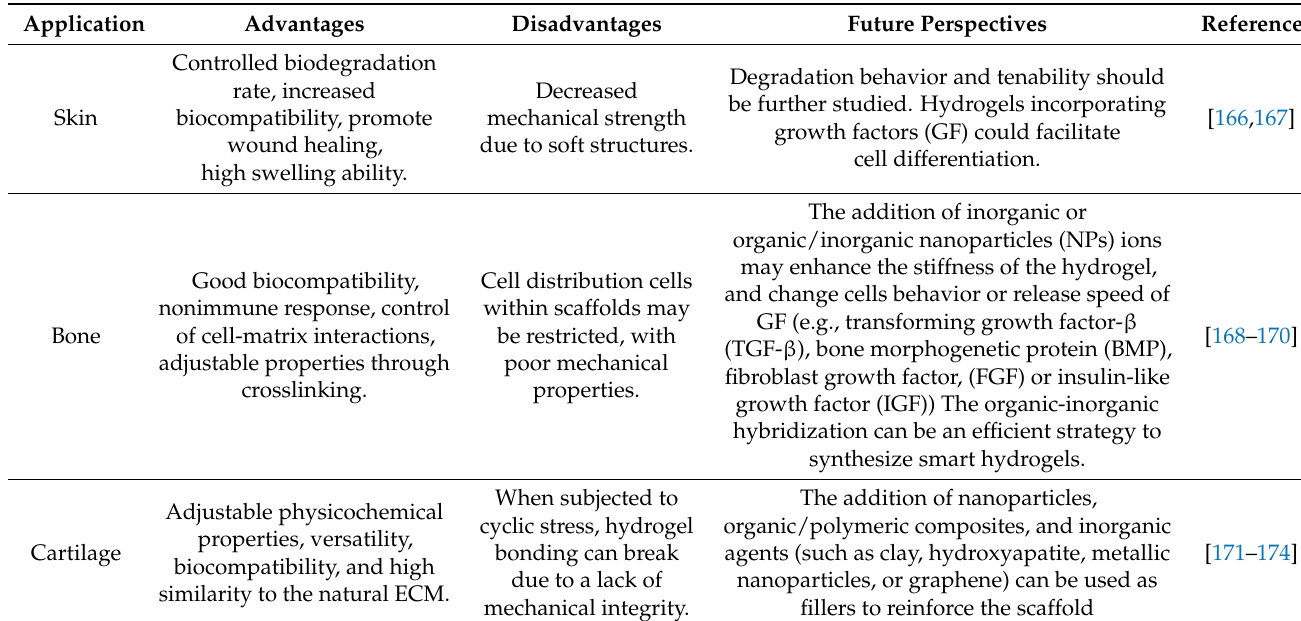
Table 4. The main advantages and limitations of hydrogels applied in tissue